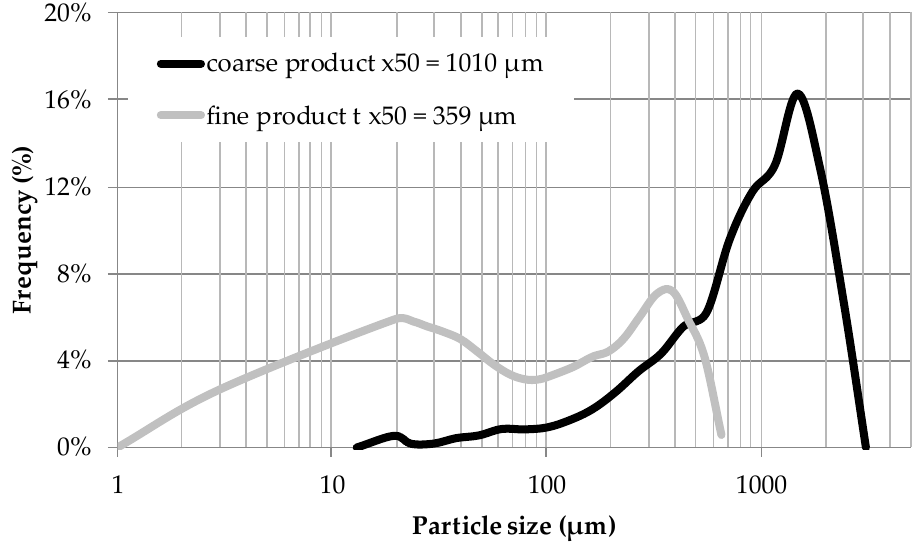
Figure 9. Particle size distributions of different feed herbal raw material batches.